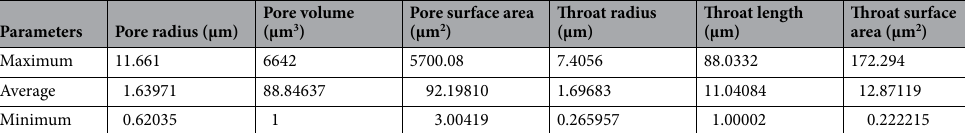
Table 8. Quantitative parameter statistics of pore network model in nylon-rubber